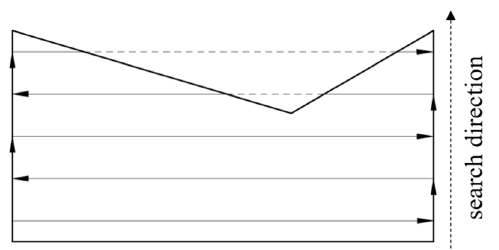
Figure 10. Coverage path of concave polygonal area before decomposition.